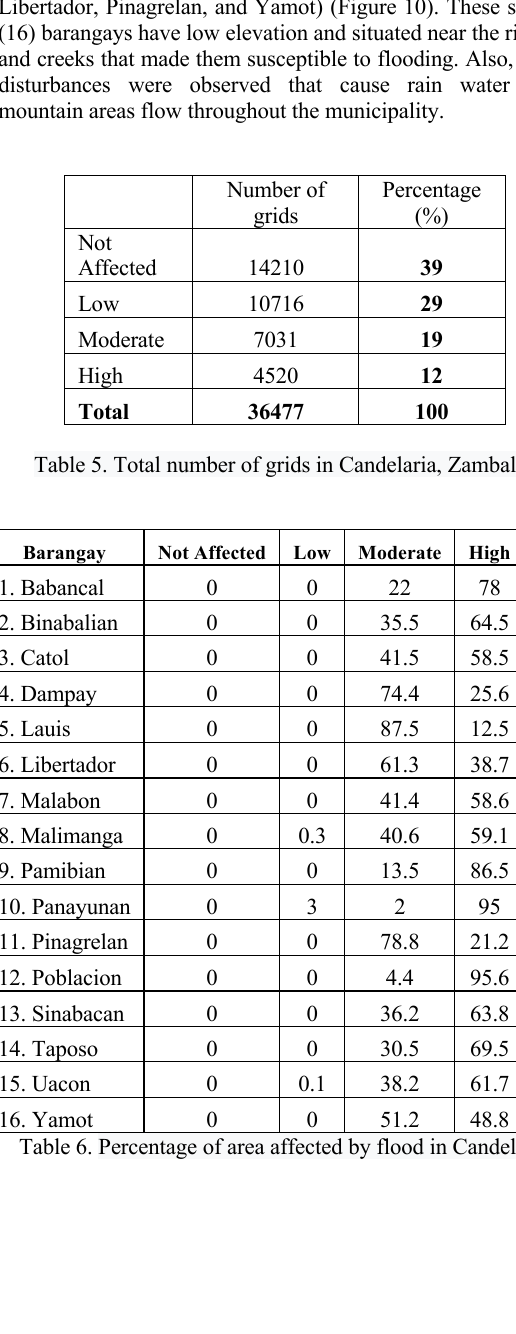
Figure 9. Flood hazard susceptibility of Sta. Cruz, Zambales